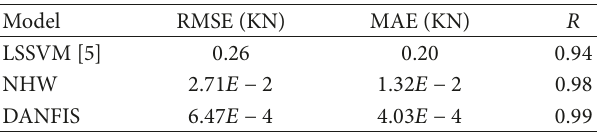
Table 6: Comparison between designed models and LSSVM [5] model for the testing